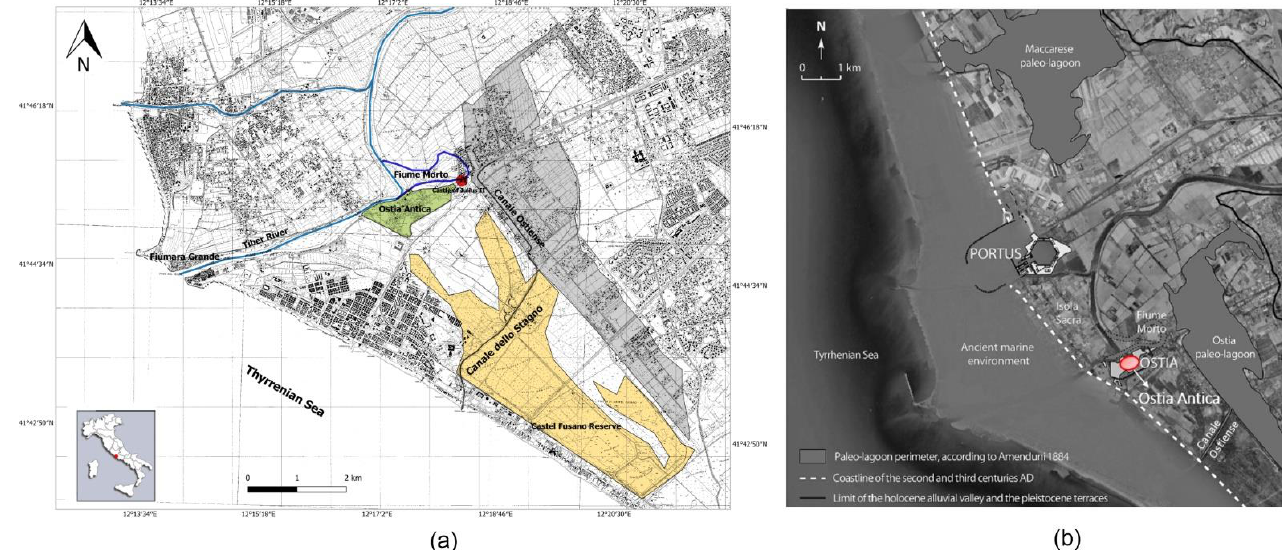
Figure 1. ( a ) Study area features: Ostia Antica archaeological park (green area), the old river meander called “Fiume Morto” with the Castle of Julius II (red dot), Tevere River (blue line), reclamation channels (thick black line), Roman salt pans (grey area), and the Castel Fusano reserve (yellow area). ( b ) Localization of the Ostia Antica archaeological park and the old meander called “Fiume Morto” with respect to paleo-lagoon areas of Ostia and Maccarese (modified from [26]).